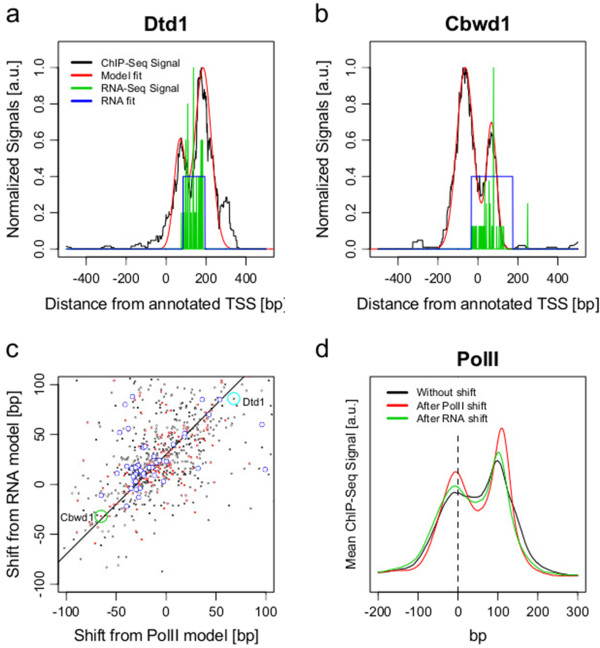
PolII and RNA-seq model fits are correlated. (a, b) Examples of two imprecise TSSs for (a) Dtd1 and (b) Cbwd1, showing the sum of Gaussians model fit (red) to PolII signal and rectangular function model fit (blue) for the RNA signal. (c) Correlation between the shifts defined by PolII and RNA-seq models for strict (black: 731 genes with R2=0.56, P<2.2×10-16) and very strict (red: 183 genes with R2=0.72, P<2.2×10-16) values of the fitting-quality criterion and TATA genes (blue). Dtd1 and Cbwd1 are highlighted with a light blue and a green circle, respectively. (d) Averaged profiles of PolII occupancy near TSS with no shift, RNA-seq model shift or PolII model shift to align first peak positions (731 genes). a.u., arbitrary units.